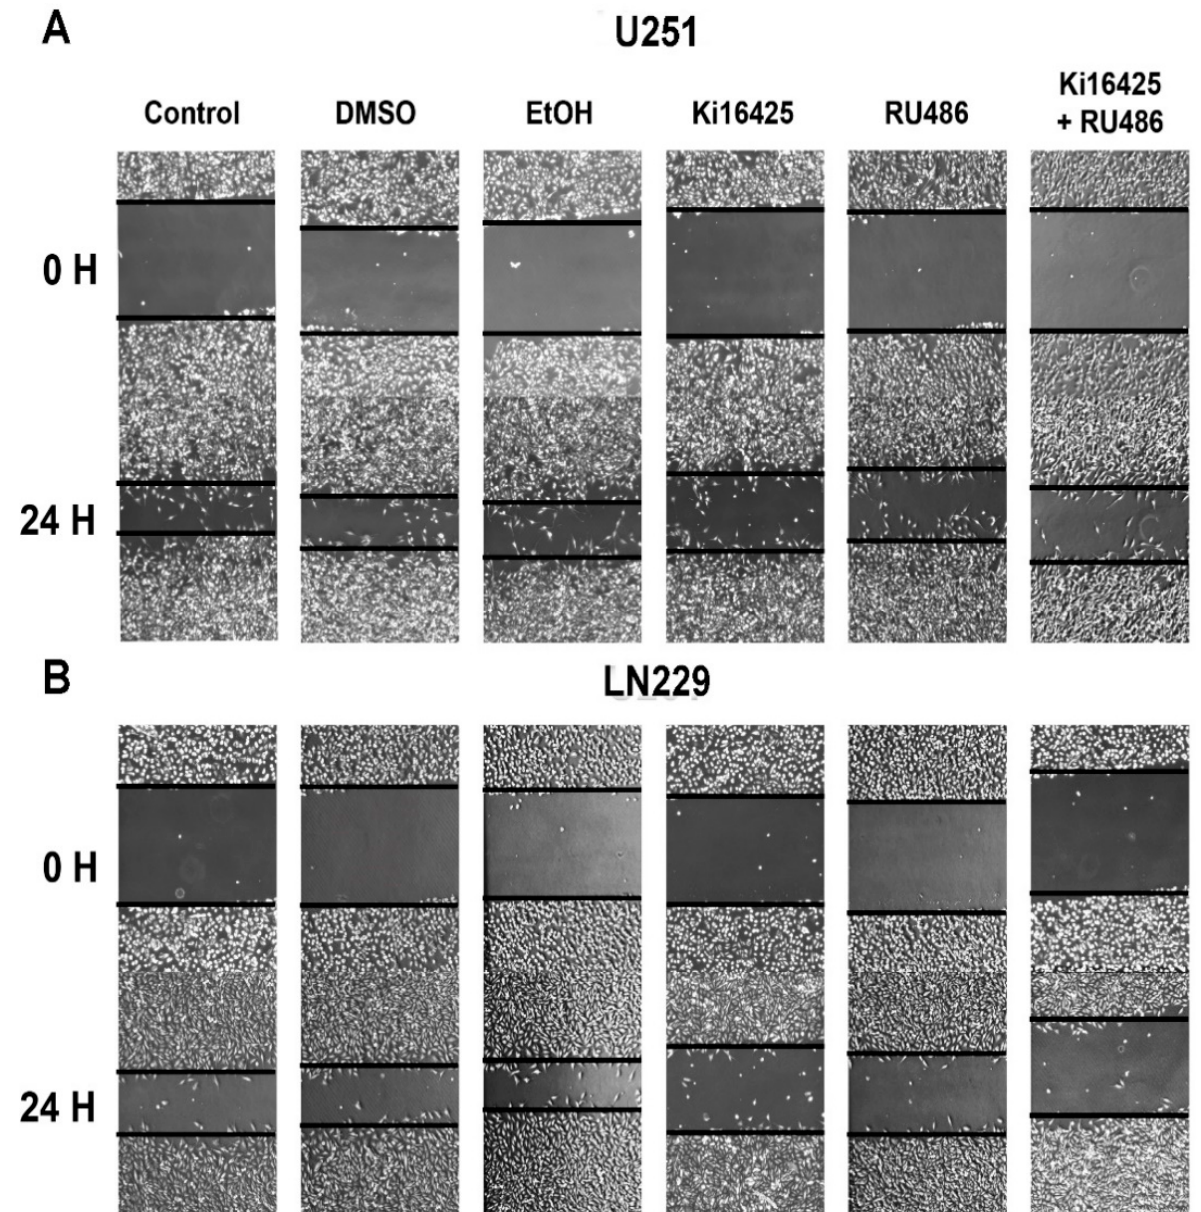
Figure 4. LPA/PR pathway signaling induces migration in GBM cells. ( A ) U251 and ( B ) LN299 cells were incubated for 24 h with complete medium (10% FBS), vehicles (DMSO and EtOH) and complete medium with Ki16425 (2.5 µM), RU486 (1 µM), or its combination. FBS was used as an LPA source. A total of 4 sections of the wound assay were analyzed per experiment and treatment. Representative images of two independent experiments are shown.